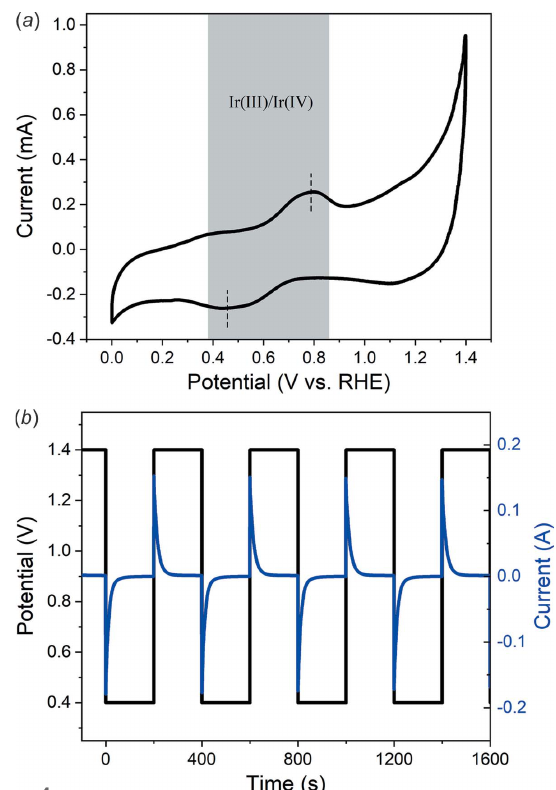
Figure 4 ( a ) CV curve of the as-prepared low-loading IrO x electrode. ( b ) CA curve of IrO x used in the modulation XAFS